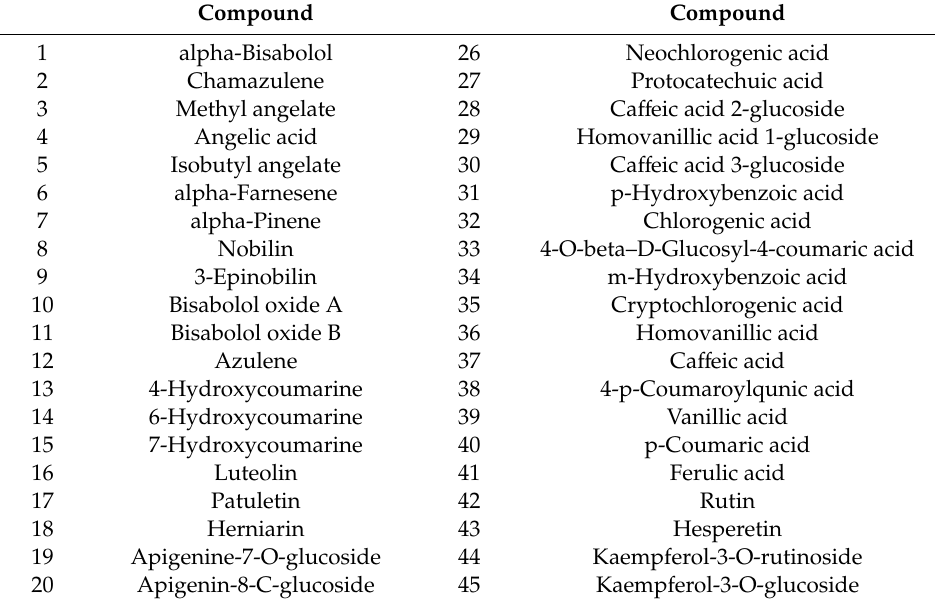
Table 1. List of polyphenols, terpenes, sesquiterpenes, fatty acids, and flavonoids screened for via LCMS /